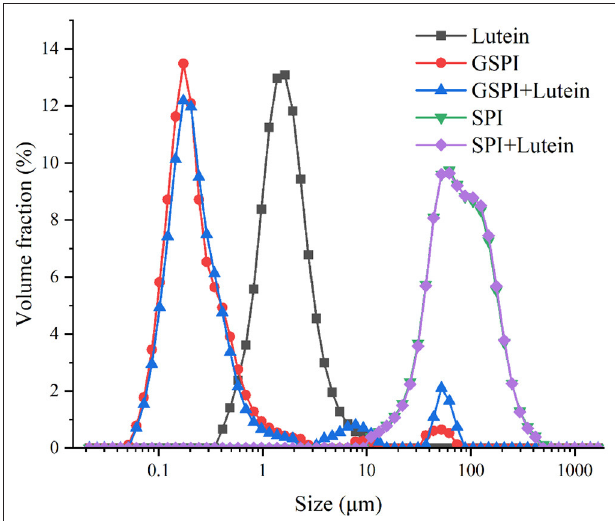
FIGURE 8 | Particle size distribution of lutein, GSPI, GSPI–lutein, SPI, and SPI–lutein.